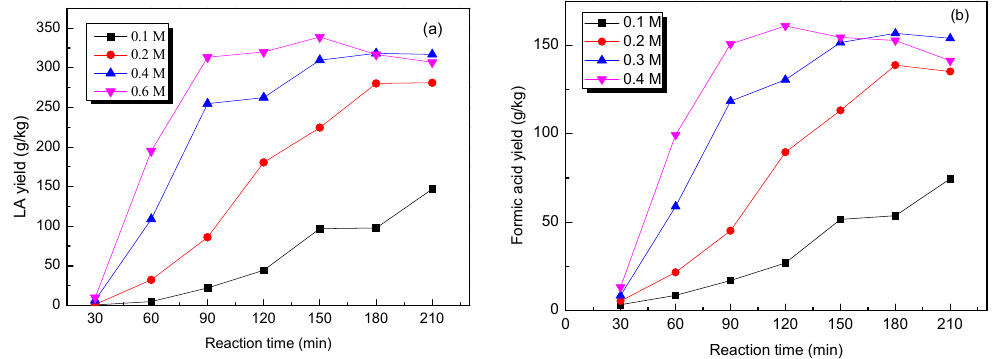
Figure 6. Effect of the acid concentration in HCl aqueous solutions on the production of ( a ) LA and ( b ) formic acid (reaction conditions: 0.3 g pretreated cow dung, HCl aqueous solution 10 mL, 180 °C).